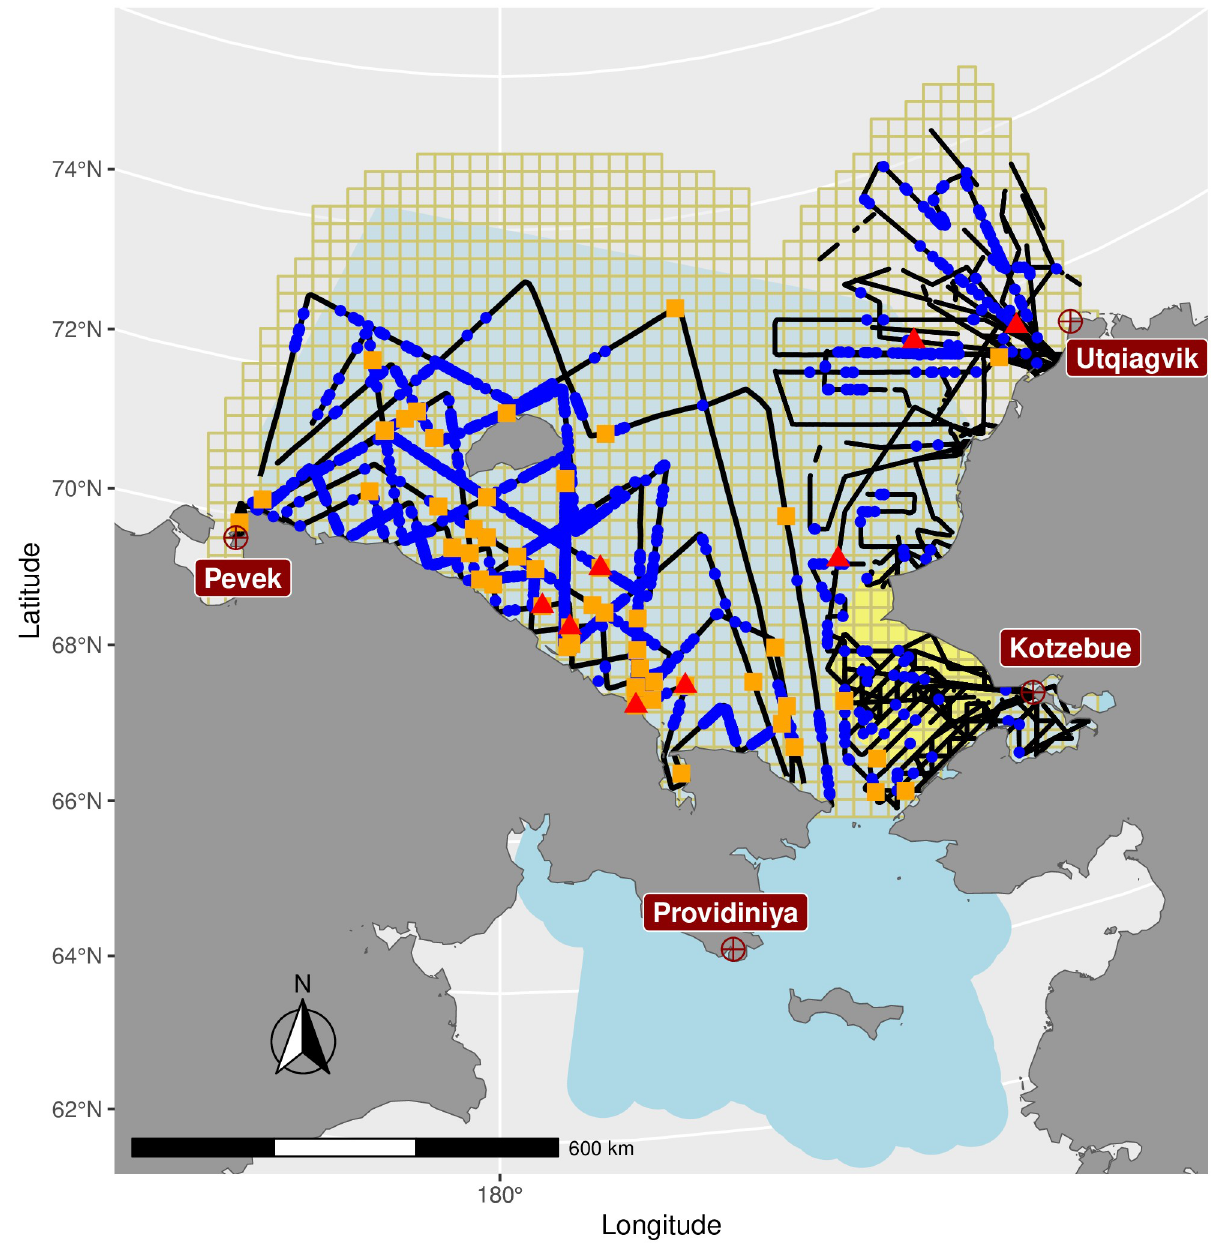
Fig 1. Chukchi Sea study area. A map of the study area used in 2016 aerial surveys for seals and polar bears. Black lines represent aerial survey tracks, while small blue circles represent locations of bear tracks. Breaks in transect lines represent times where survey crew went “off effort” because of dense fog. Red triangles represent thermal detections of polar bear groups, and orange squares represent additional groups seen by human observers (U.S. and Russia) or in post hoc examination of photographs (Russia only). The � 625km 2 grid cells used for abundance estimation appear in the background (beige lines). Land masses (gray) include Alaska, U.S.A. to the east and Russia, to the west. The blue shading represents the area associated with the Chukchi subpopulation of polar bears as determined by the polar bear specialist working group (PBSG), while yellow shading shows the area where a long term capture-recapture study of polar bears [8] was previously conducted. For an animation depicting survey effort and observations overlayed on sea ice as a function of survey day, see S1 Video.